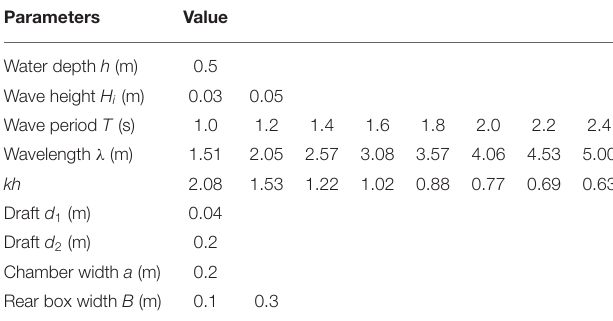
TABLE 1 | Experimental test conditions and model